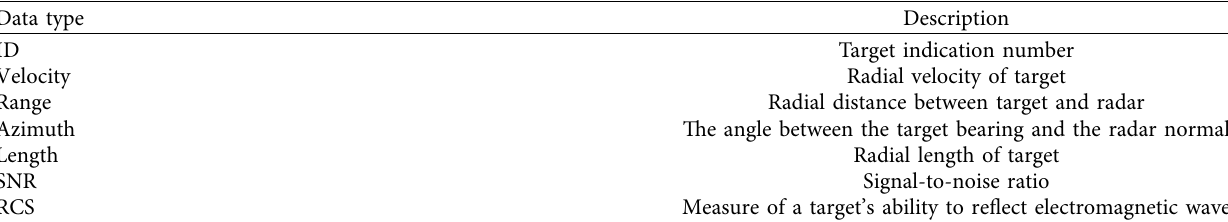
Table 1: Radar output data